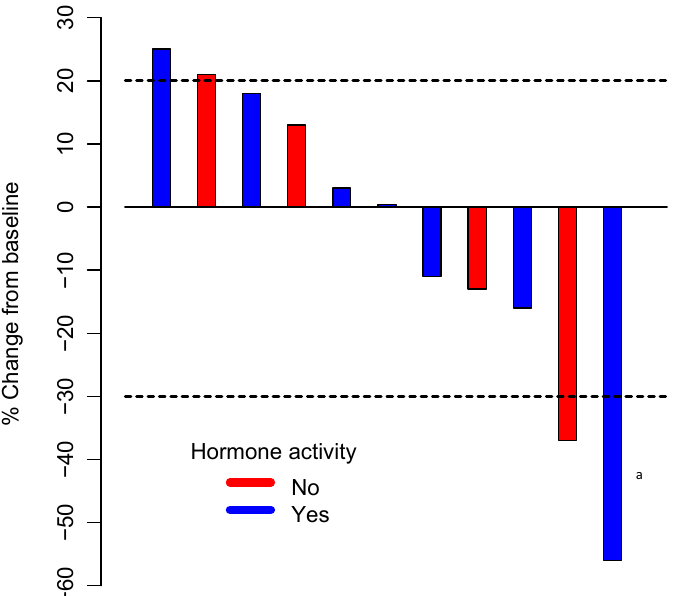
Figure 1. Waterfall plot illustrating the best response to pembrolizumab therapy in 11 patients. The area below the lower dotted line represents a partial response (30% decrease in the sum of diameters of target lesions compared with the baseline); the area between the two dotted lines represents stable disease; and the area above the upper dotted line represents progressive disease (20% increase in the sum of the diameters of target lesions compared with the smallest sum during the study), based on immune-related Response Evaluation Criteria in Solid Tumors. a Patient with progressive disease (unconfirmed partial response).